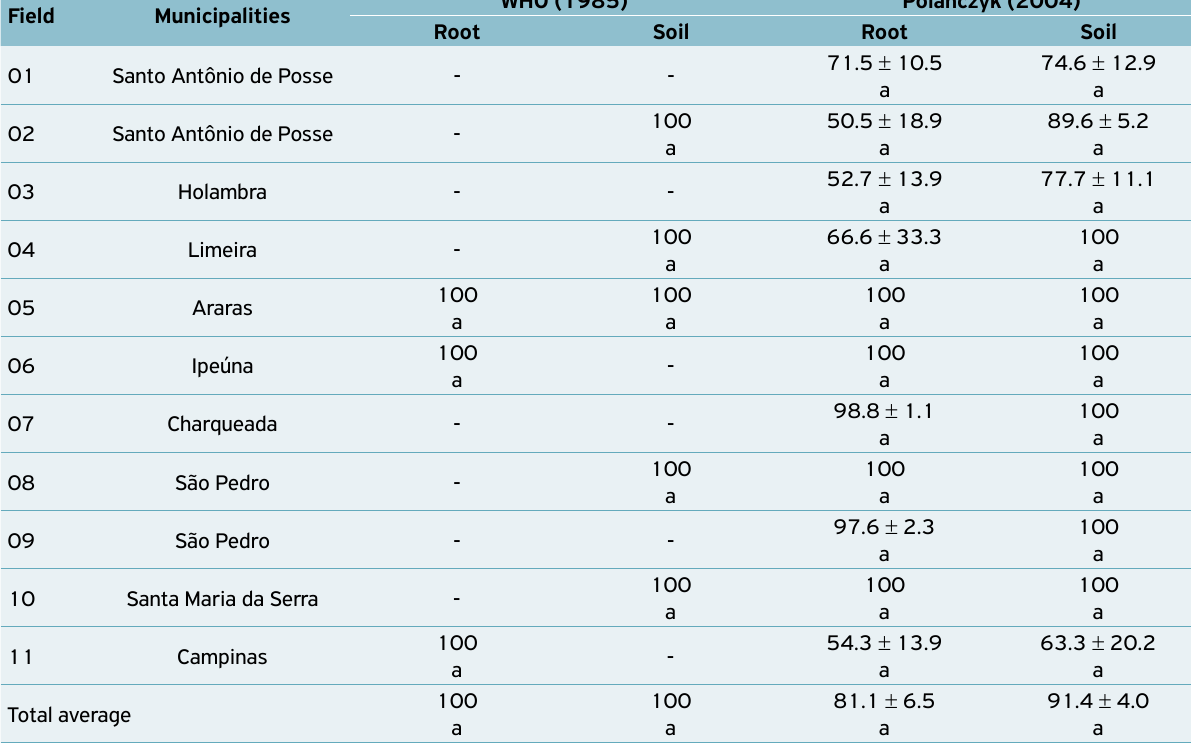
Means with the same letter in column for data, and in row for total average, are not significantly different by Tukey’s test at the 5% significance